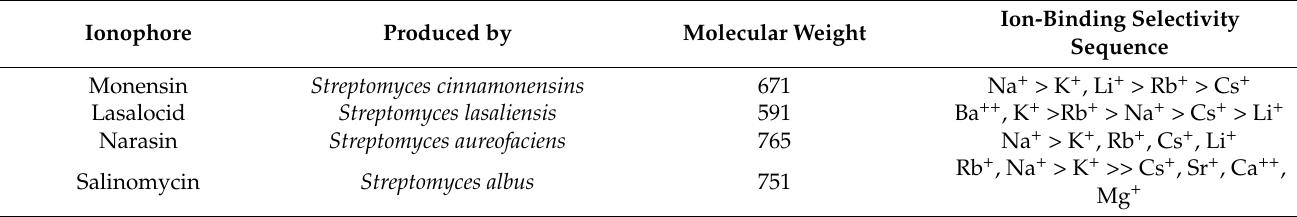
Table 1. Ionophores characteristics and ion-binding selectivity preference 1